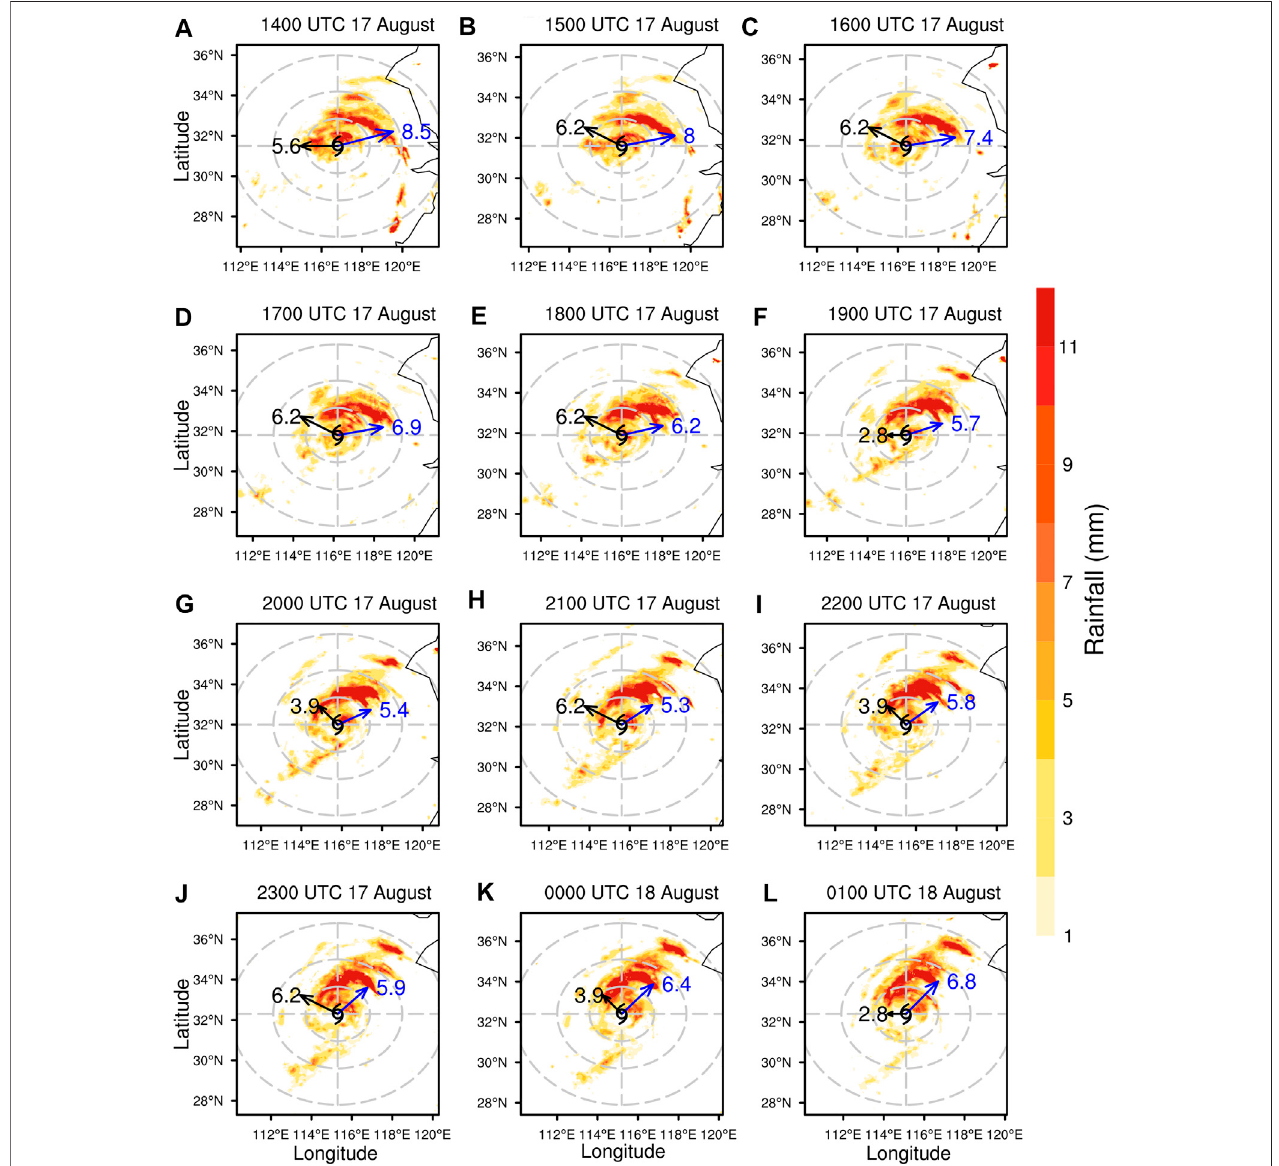
FIGURE 8 | Same as Figure 6 , but at (A) 1,400, (B) 1,500, (C) 1,600, (D) 1700, (E) 1800, (F) 1900, (G) 2000, (H) 2,100, (I) 2,200, (J) 2300 UTC 17 August, (K) 0000, (L) 0100 UTC August 18.